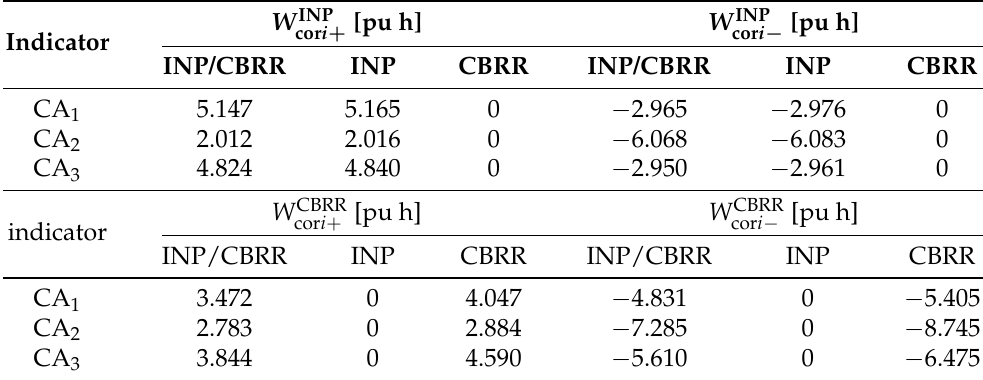
Table 5. Energy exchange.